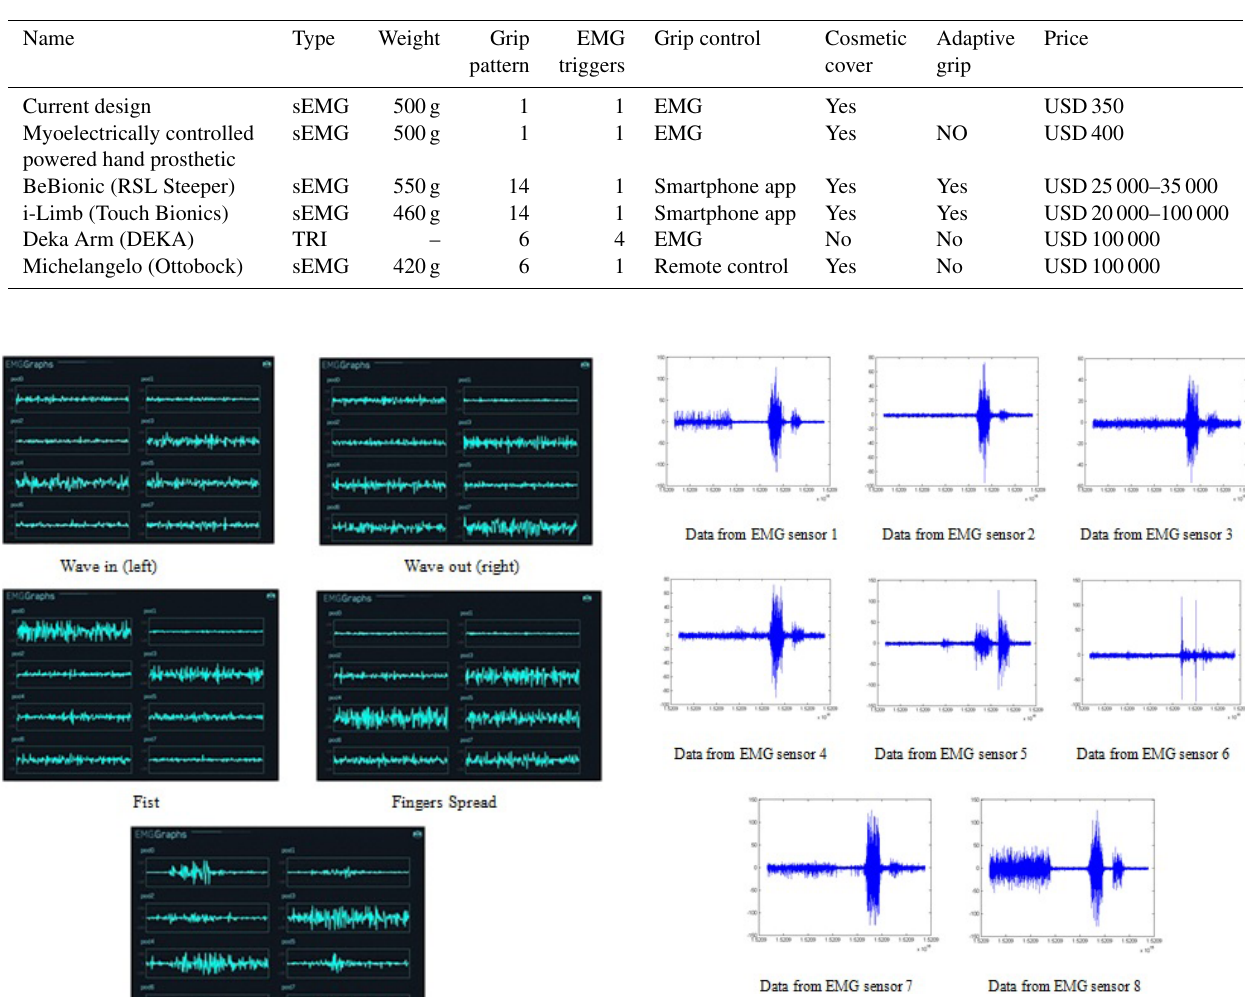
Table 2. Comparison of existing commercial myoelectric prosthetics and our design.